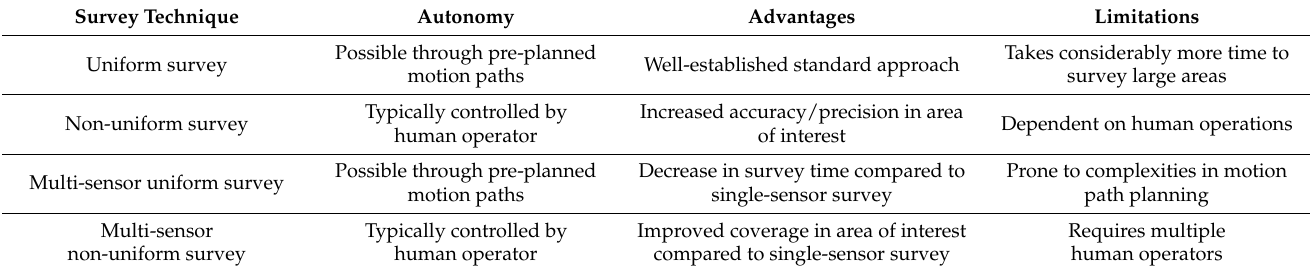
Table 1. Summary of advantages and limitations of typical survey methods for radiological contami- nation